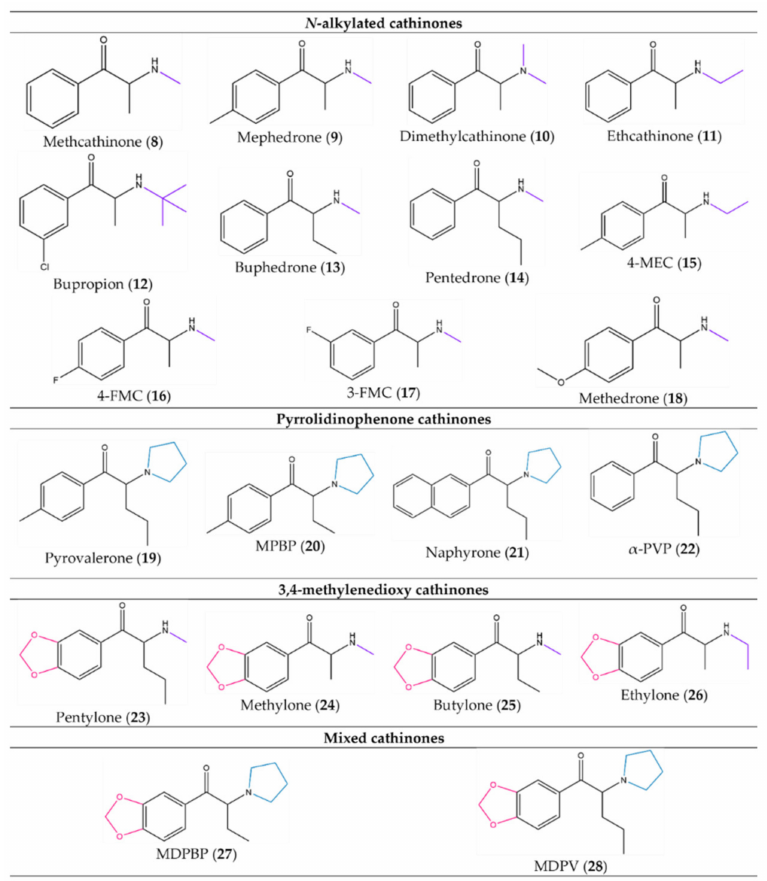
Figure 5. Examples of synthetic cathinones from each group based on the substitution pattern: ( 8 )–( 18 ) from the N -alkylated cathinones, ( 19 )–( 22 ) from the pyrrolidinophenone cathinones, ( 23 )–( 26 ) from the 3,4-methylenedioxy cathinones and ( 27 ) and ( 28 ) from the mixed